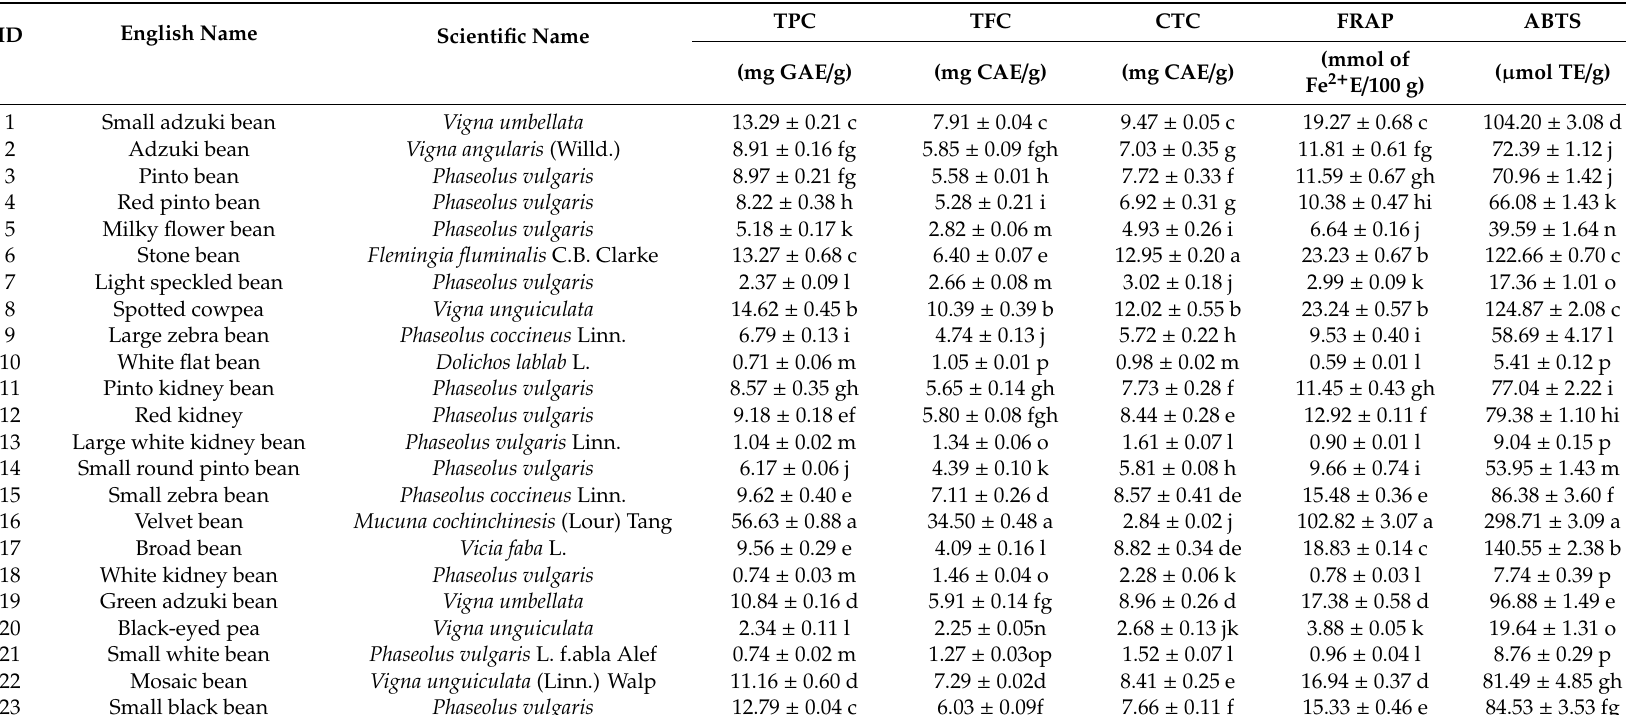
Table 1. Total phenolic content (TPC), total flavonoid content (TFC), condensed tannin content (CTC) and antioxidant capacities (ABTS and Ferric Reducing Antioxidant Capacity (FRAP) values) of 23 food